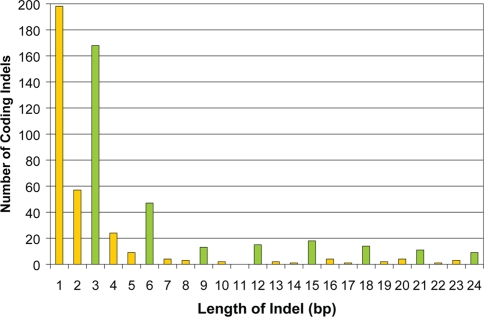
The size distribution of coding indels.Coding indels are predominantly the size of 3n, where n is an integer. 3n coding indels do not cause frameshifts, whereas non-3n coding indels do.